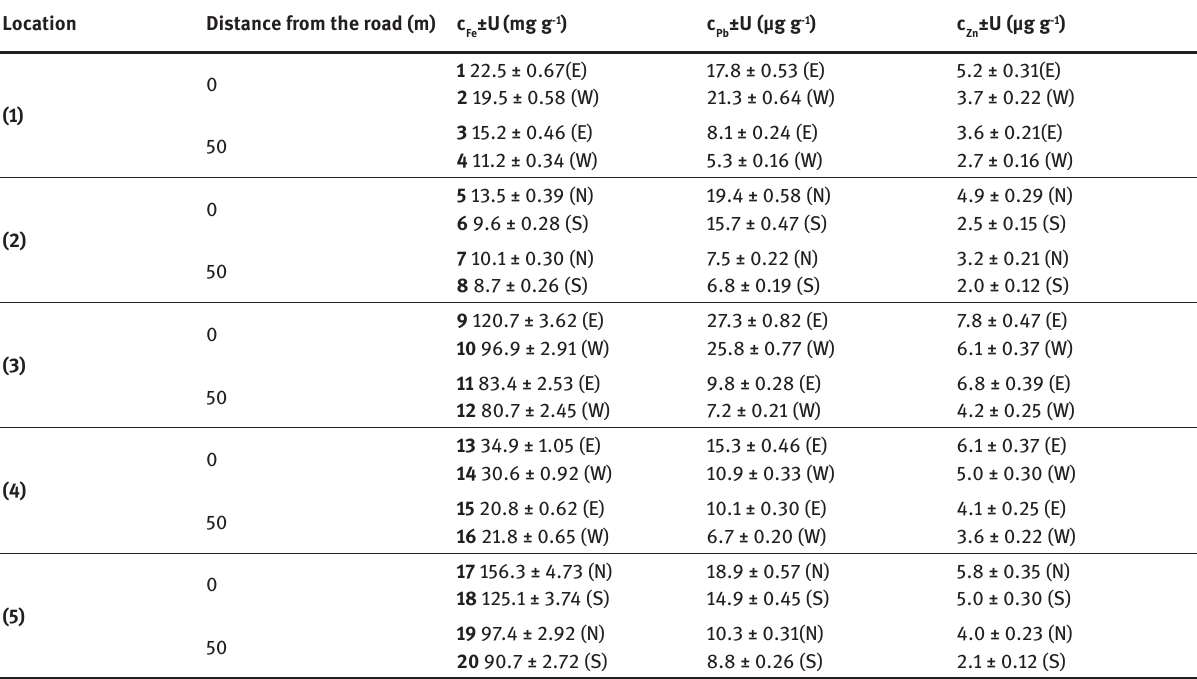
Table 2: Concentrations of Fe, Pb and Zn in soil samples depending on the distance from the road.